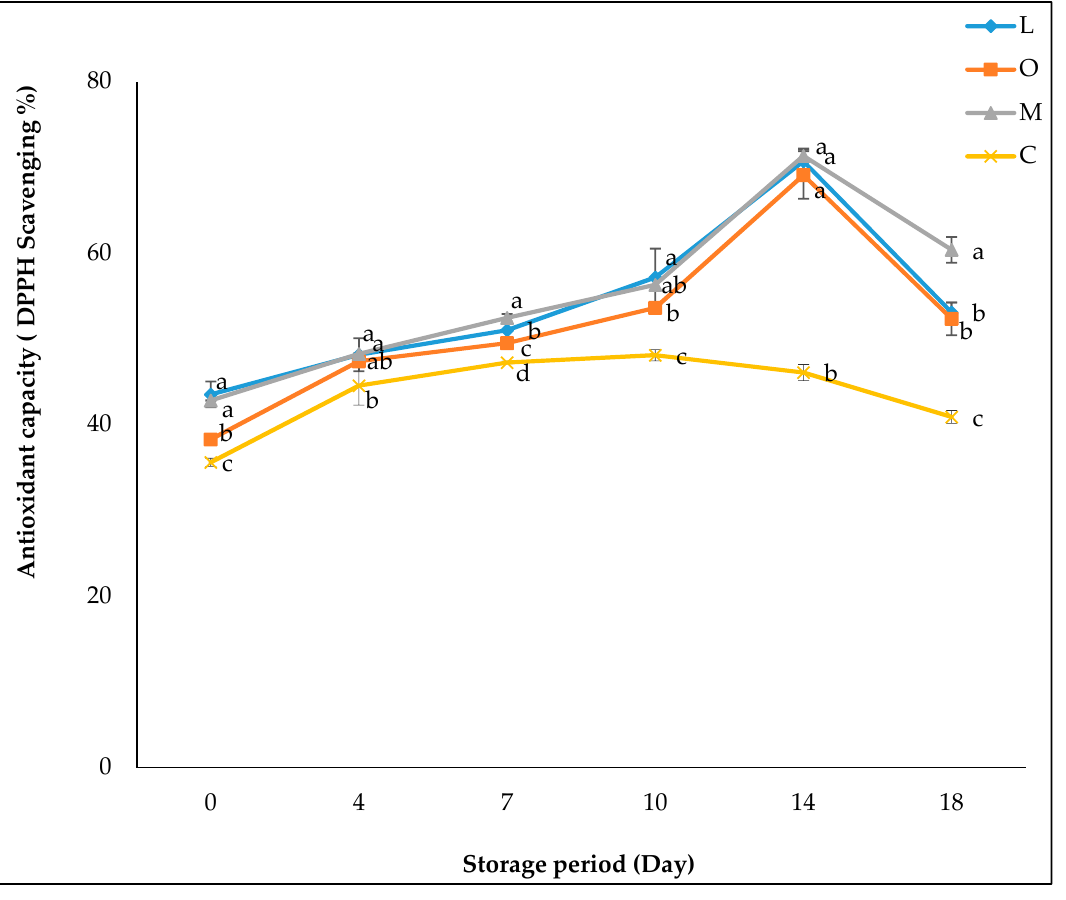
Figure 12. Effect of different essential oil emulsions (L = lemon, O = orange, and M = mandarin Figure 12. E ff ect of di ff erent essential oil emulsions (L = lemon, O = orange, and M = mandarin essential essential oil) on antioxidant capacity of strawberry fruits stored at 2 °C for 18 days. Vertical bars oil) on antioxidant capacity of strawberry fruits stored at 2 ◦ C for 18 days. Vertical bars indicate the indicate the standard deviation (n = 6). Means and different letters indicate significant difference standard deviation (n = 6). Means and di ff erent letters indicate significant di ff erence between treated between treated and control fruits at each storage period (Duncan’s of 95%). and control fruits at each storage period (Duncan’s of